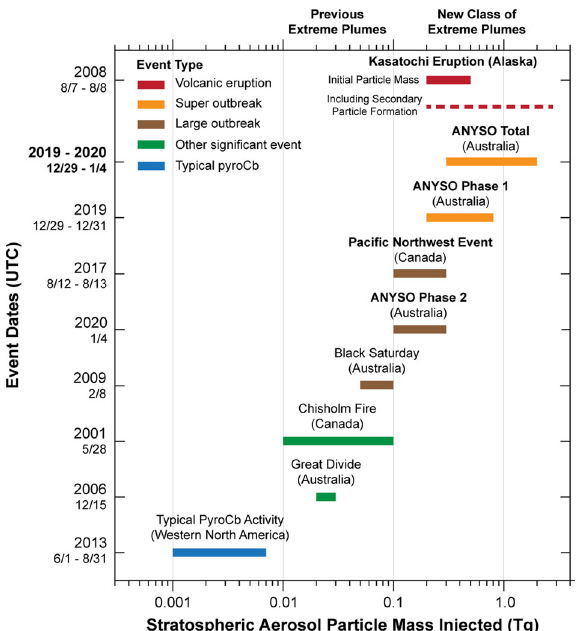
Fig. 3 ANYSO compared with stratospheric particle mass esti- mates from other events. Bars indicate the approximate uncertainty range of stratospheric aerosol particle mass injected. All mass estimates are displayed using a logarithmic scale (x-axis). Color scheme indicates event type and characteristics. This display expands upon an earlier version provided in our previous study 2